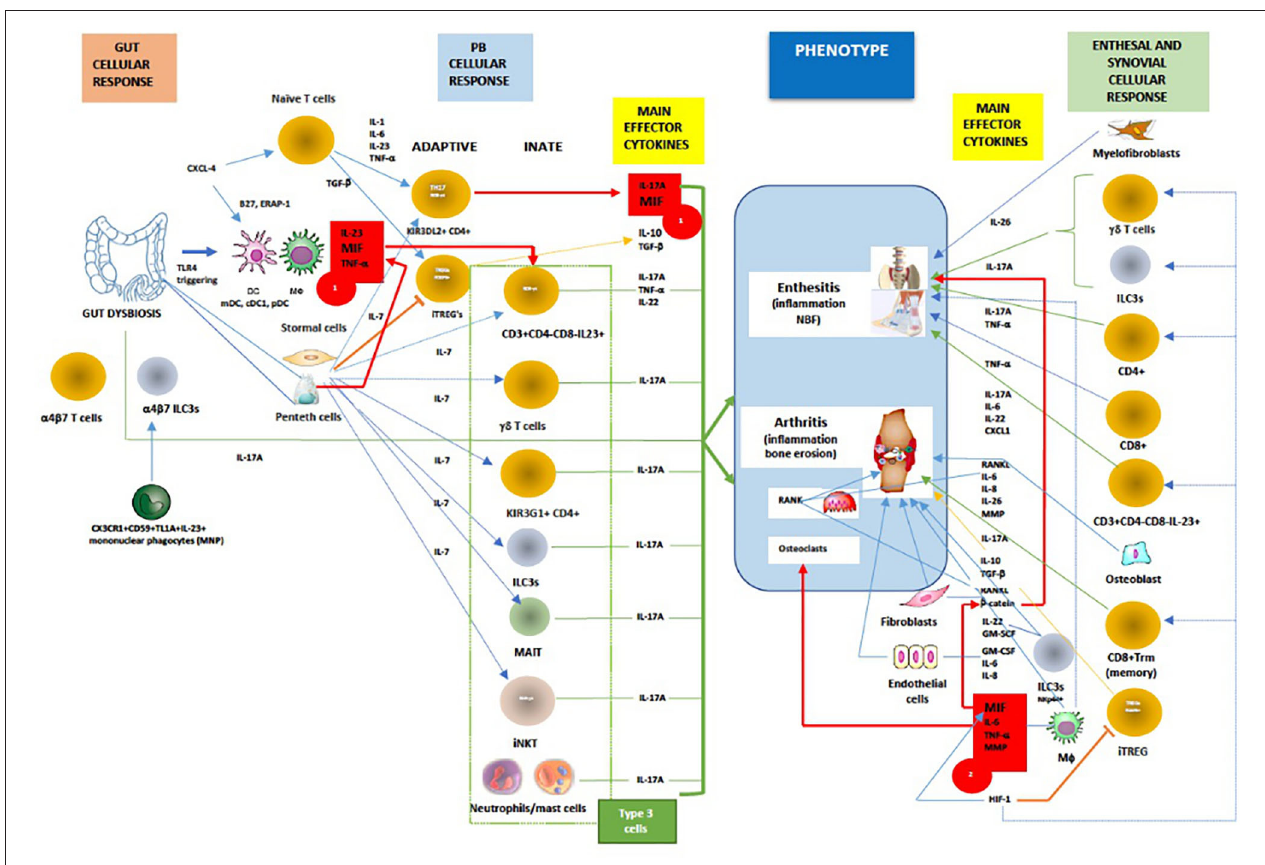
FIGURE 3 | In general, MIF is an proximal mediator of host defense that up-regulates the expression of pattern recognition receptors (eg TLR-4) and perpetuates inflammatory responses by inhibiting activation-induced apoptosis in monocytes and macrophages. As mentioned above in chronic spondyloarthritis the inhibitory effect of glucocorticoids on cytokine mRNA translation may be counter-regulated by MIF. Furthermore, dysbiosis could trigger TLR-4 ligands to induce ileal production of MIF, especially in CD163 + macrophages, DCs and Paneth cells, which consequently activates CD14 + monocytes to produce TNF- α /IL-23 and primes adaptive and innate (Type 3) immune cells to produce IL-17A ( Red box 1 ). Chemokine CXCL4 ( MIF co-receptor ) promotes IL-17 production in human CD4 + T cells by acting both directly on CD3/CD28-activated human (naive) CD4 + T cells or indirectly via myeloid antigen presenting cells (mDCs). On the other hand, IL-7 is a cytokine that, better than IL-23, stimulates IL-17 production in both innate and adaptive immunity, and suppress the function of regulatory T cells (Treg). High levels of IL-7 have been confirmed both in the intestinal tissue and in the inflamed synovium of patients with AS. The tissue-resident γδ T cells, ILC3s, circulating and/or gut-derived α 4 β 7 γδ T cells, T H 17 cells, or mucosal associated invariant T (MAIT) cells all are known to promote IL-17-driven joint/entheseal inflammation. MIF, along with TNF- α and other pro-inflammatory cytokines, also induces synovitis and enthesitis with bone erosions. Joint hypoxia induces hypoxia inducible factor (HIF) expression